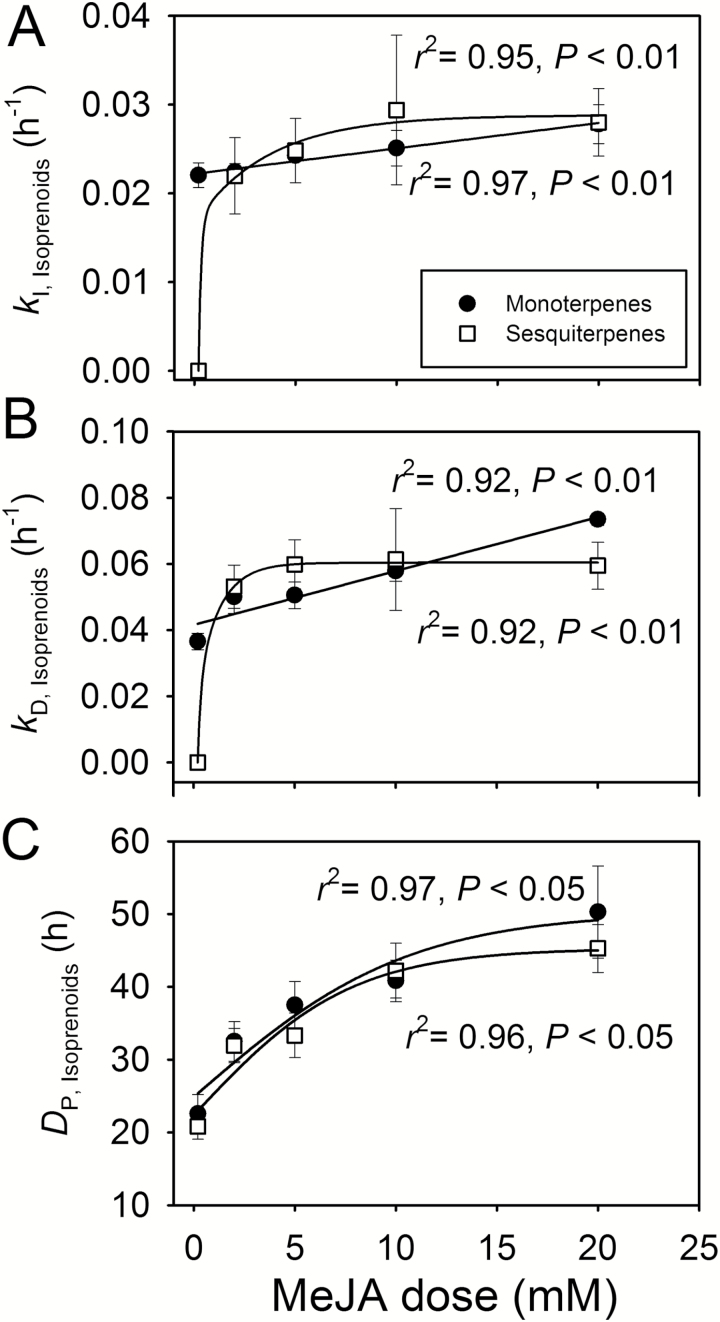
First-order rate constants (kI) for the initial increases (Equation 2, kI; A) and decreases (Equation 3, kD; B) of the MeJA-induced emissions for mono- (kI,monoterpene and kD,monoterpene) and sesquiterpenes (kI,sesquiterpene and kD,sesquiterpene) and the durations (C) of monoterpene (DP,monoterpene) and sesquiterpene (DP,sesquiterpene) emission bursts in relation to MeJA concentration in C. sativus leaves (see Fig. 2 for sample responses). Experimental treatments are as in Fig. 1 and data availability is as in Fig. 3. The regressions fitted to the data as: y=0.0029x+0.22 for kI,monoterpene and y=0.297x/(0.736+x) for kI,sesquiterpene in (A), y=0.0016x+0.041 for kD,monoterpene and y=0.061x/(0.295+x) for kD,sesquiterpene in (B), y=50.3/[1+e(0.107−x)/5.26] for DP,monoterpene and y=45.3/[1+e(0.0784−x)/3.84)] forDP,sesquiterpene in (C). Altogether three replicate treatments at each MeJA application concentration were carried out.